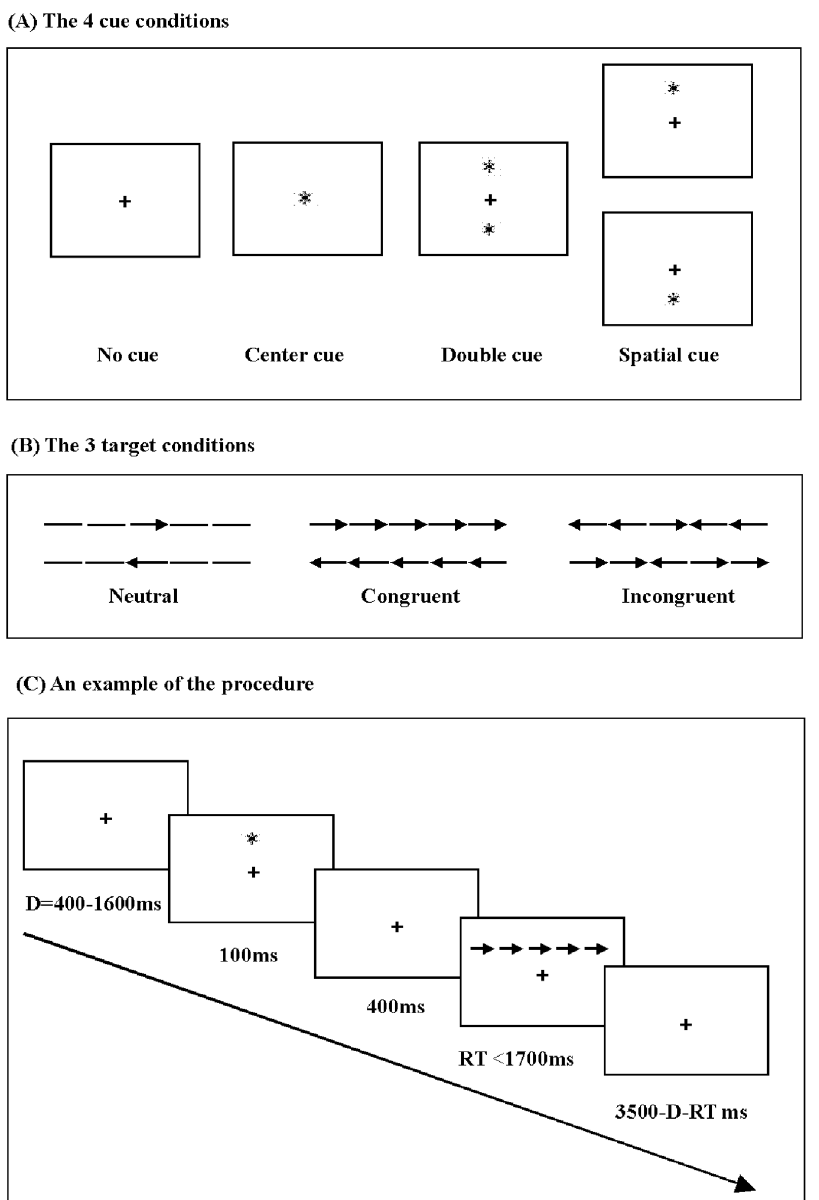
Figure 1. The flow chart of experimental process: (A, the four cue conditions; B, three target conditions; C, an example of the procedure). RT=reaction